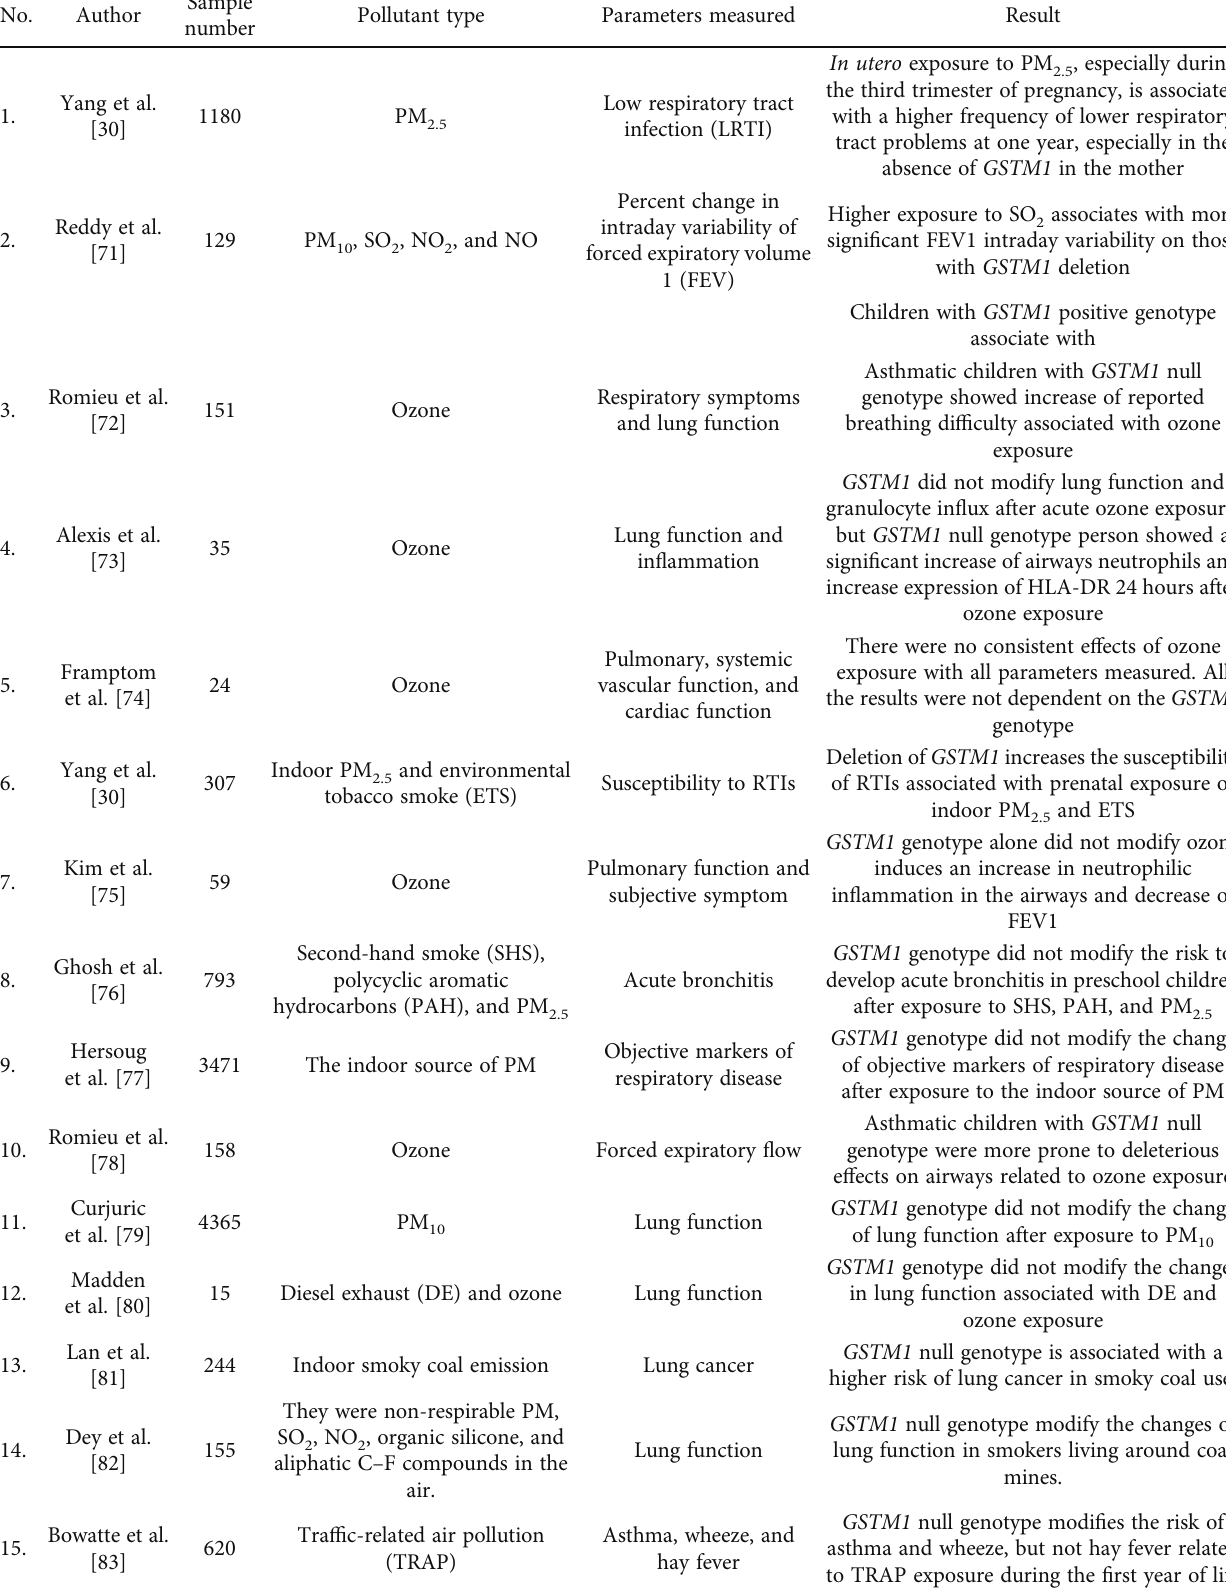
Table 2: Studies of the e ff ect of GSTM 1 absence on respiratory